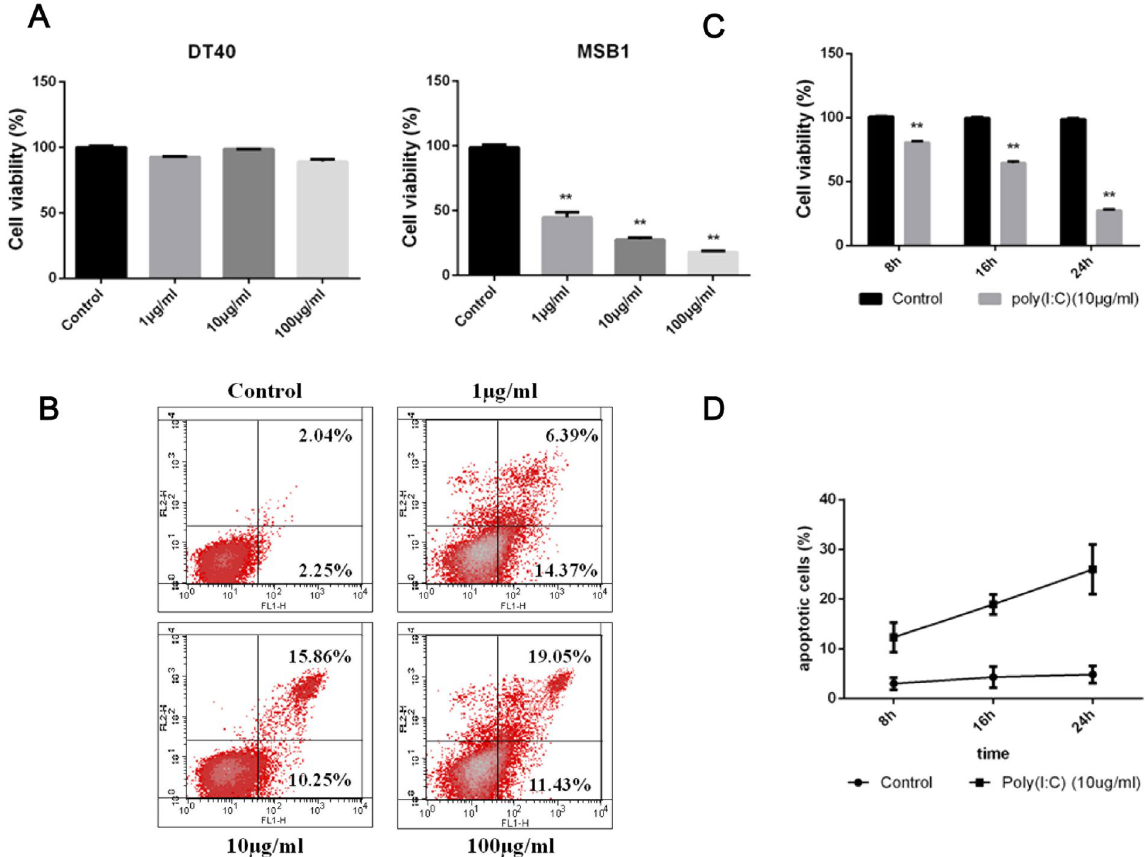
Figure 1. Apoptosis of chicken lymphoma cells is induced by the synthetic dsRNA analogue poly (I:C). ( A ) Chicken lymphoma cells were cultured with or without increasing doses of poly (I:C) (1 μ g/ml, 10 μ g/ml, 100 μ g/ml) poly (I:C) for 24 h and viability is expressed as a percentage. ( B ) MDCC-MSB1 cells were cultured for 24 h with or without increasing doses of poly (I:C) (1 μ g/ml, 10 μ g/ml, 100 μ g/ml), and apoptosis was detected by annexin V and PI staining. ( C ) MDCC-MSB1 cells were cultured with or without poly (I:C) (10 μ g/ ml), and the percentage of cell viability was measured at the indicated time points. ( D ) MDCC-MSB1 cells were cultured with or without poly (I:C) (10 μ g/ml) and the percentage of apoptotic cells expressed as a percentage at the indicated time points. The asterisk ( * ) or double asterisk ( ** ) respectively indicates p < 0.05 or p < 0.01 in statistical difference from controls. The bars represent an average of multiple